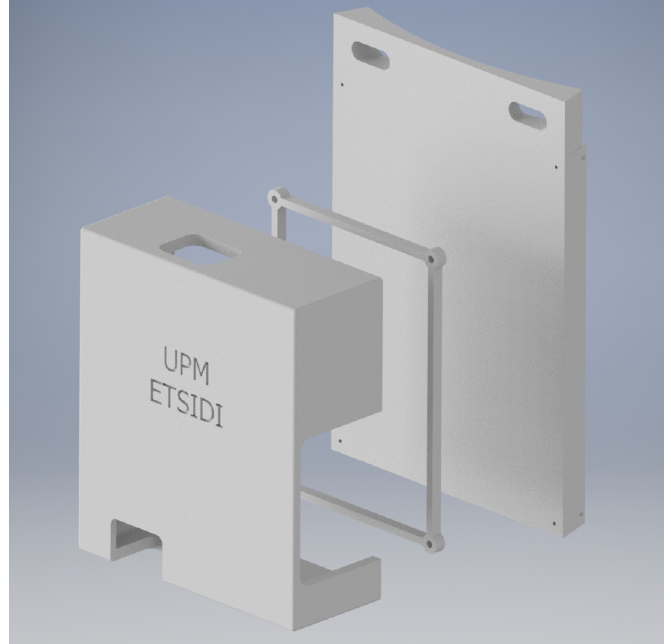
Figure 14. Three-dimensional (3D) printed box for the electronic